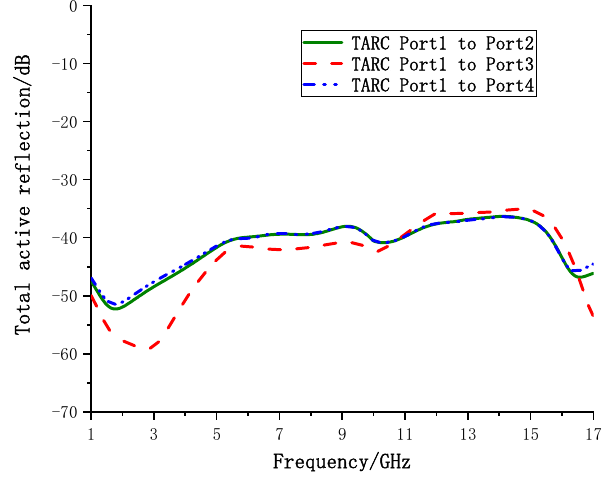
Figure 18. The TARC curves for the UWB MIMO antenna. Table 3. Compares the proposed antenna with other MIMO antennas in the references.